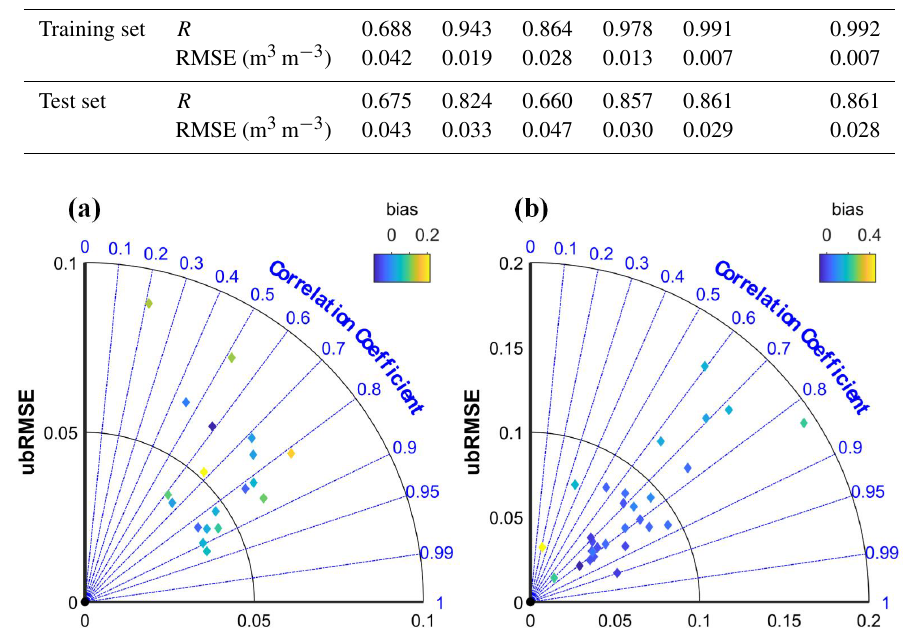
Figure 6. The relationships between in situ SM and downscaled SM. (a) Maqu network and (b) Babao network.